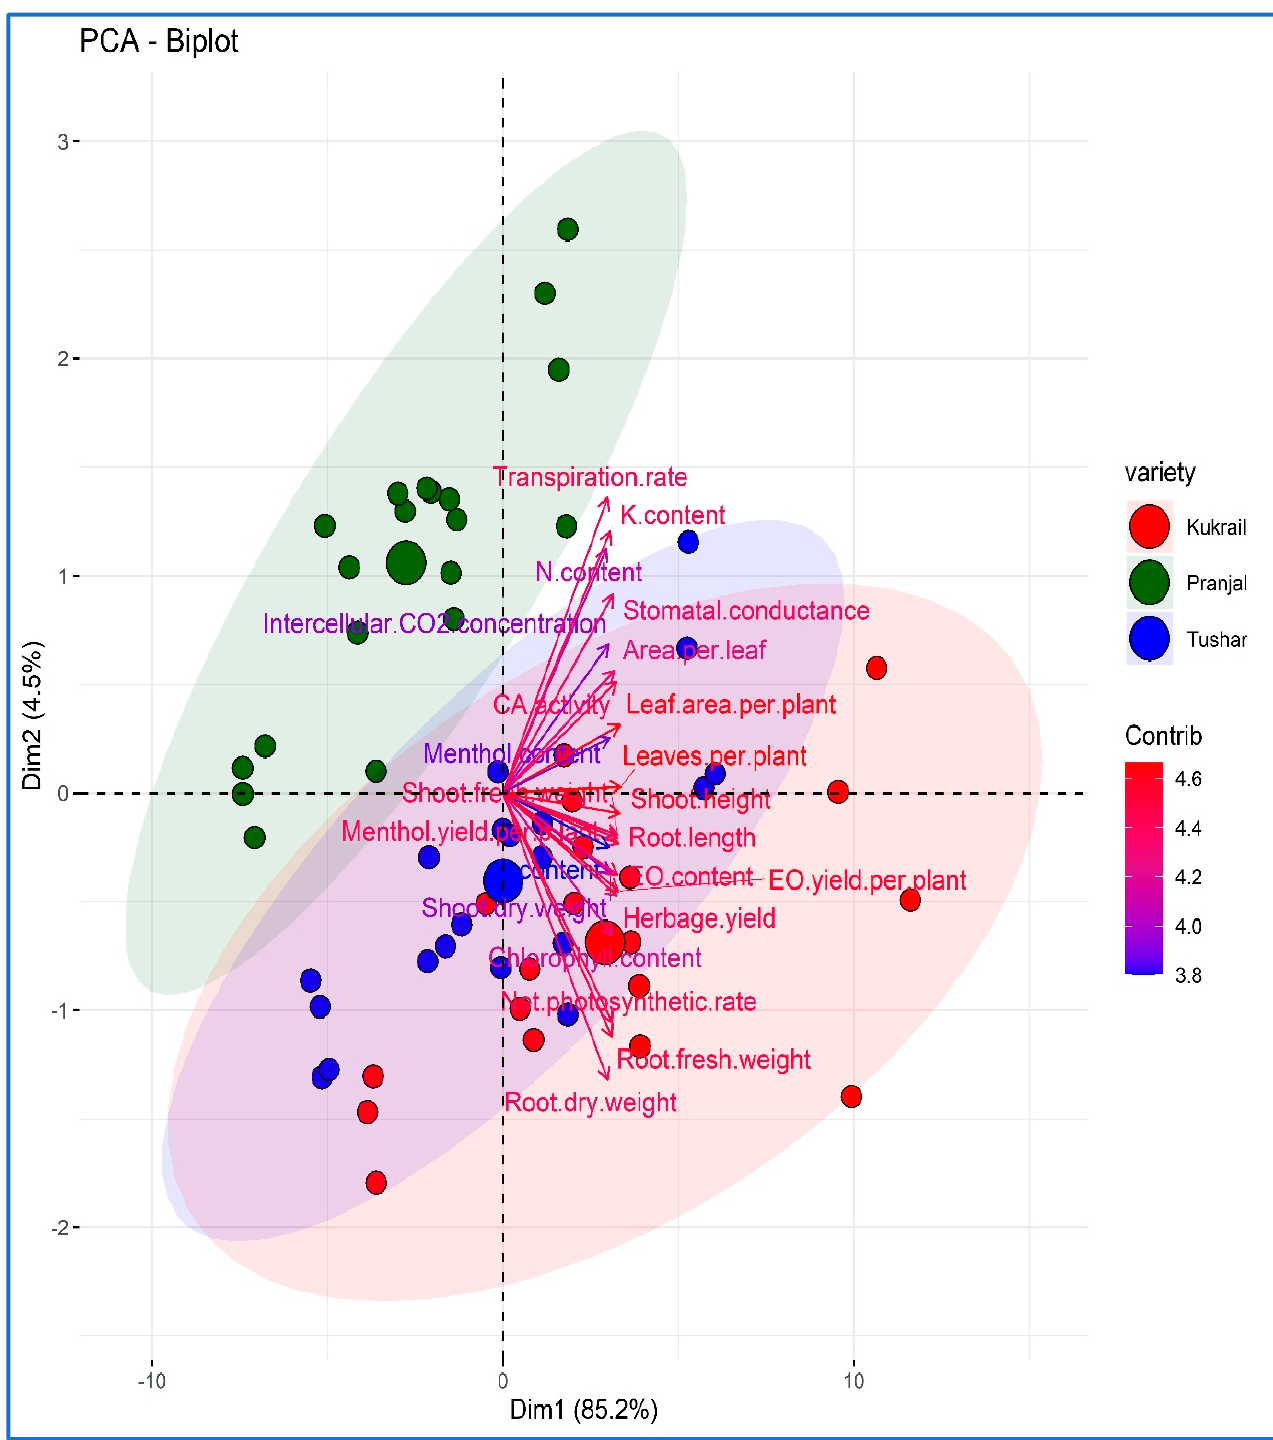
Figure 13. PCA-biplot depicting the effect of N on the performance of three studied cultivars of peppermint.